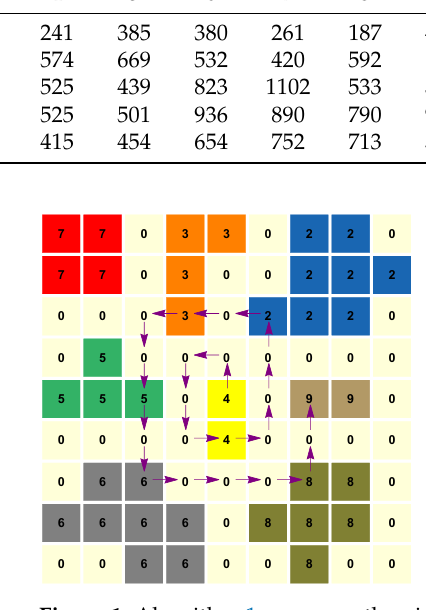
Figure 1. Algorithm 1 runs over the pixels following a spiral until the desired number of labels (of cells) is reached. In this toy example, taking as input parameter N = 7, the output is the set of labels C = { 4,2,3,5,6,8,9 } . Boundary pixels are labeled by